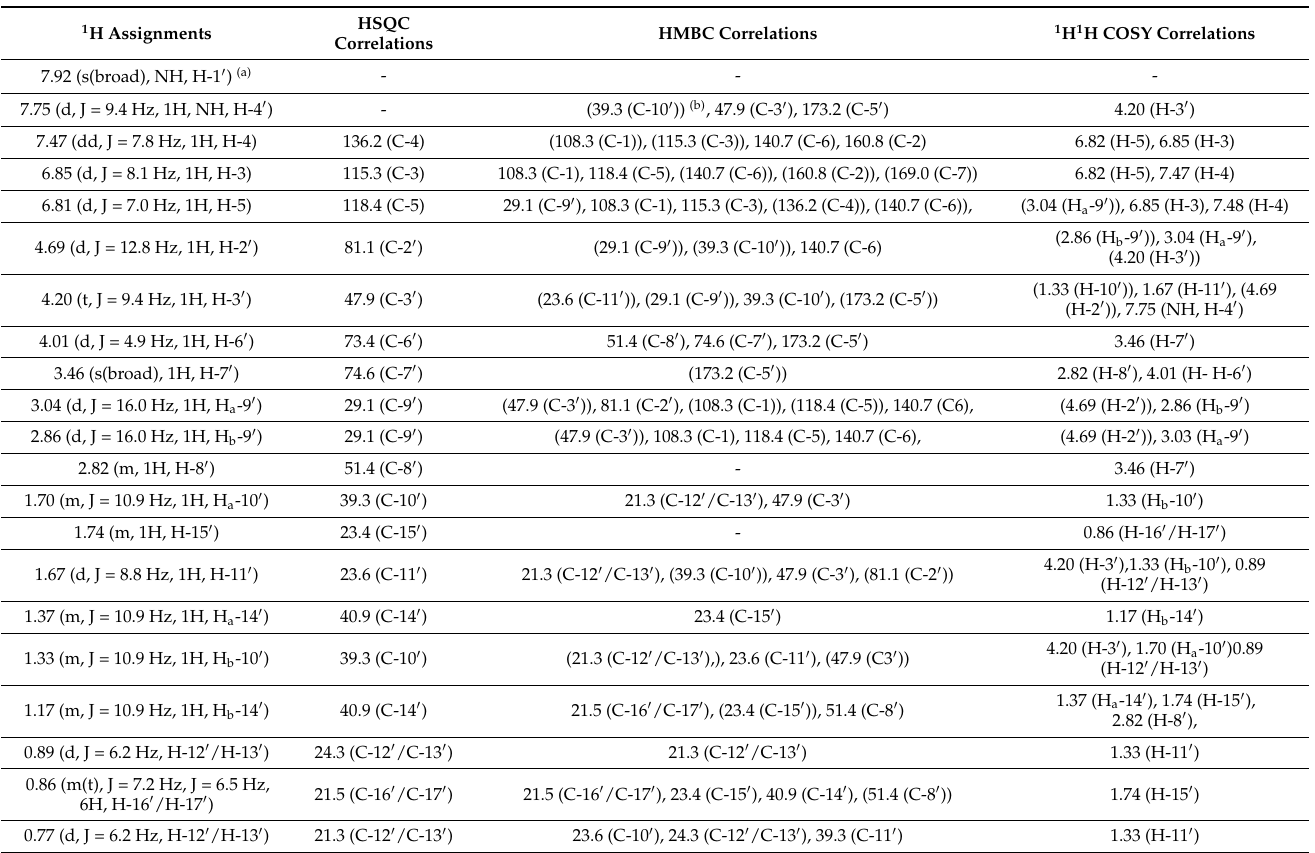
Table 7. 1 H assignments, HSQC, HMBC and 1 H 1 H COSY correlations for PP1. ( 1 H